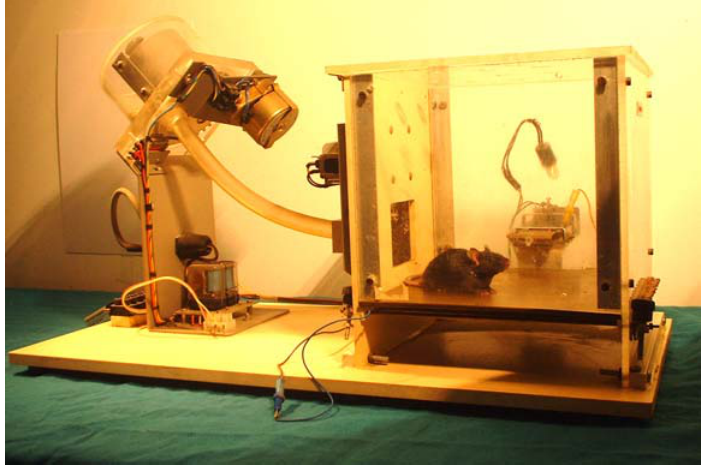
FIGURE 2. Mice in a conflict situation . In a Skinner box, a mouse can obtain a food reward by pressing a lever. In a conflict situation, when a light is on and when the mouse presses the lever, it obtains the food reward and also a mild electric shock via the metal floor and the lever. Anxious mice pressed the lever less frequently in the conflict situation, but there was little or no change to the lever pressing by nonanxious mice. (Copyright Venault and Chapouthier,